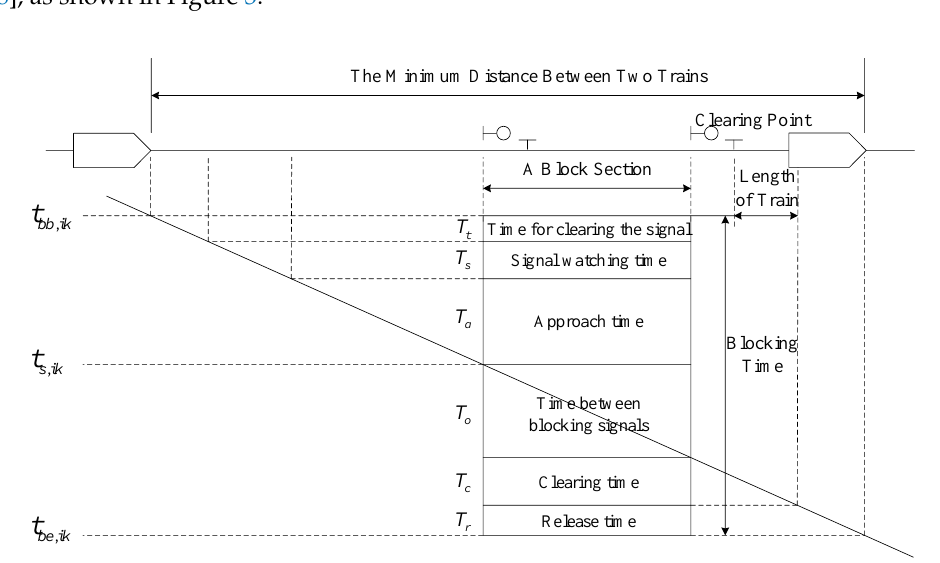
Figure 4. Diagram of the composition of the blocking time when a train has a scheduled stop. After a commercial stop, a train should leave that station. At this time, the approach time does not apply. Moreover, we used a clearing point to divide the block section behind the station into two parts. Figure 5 shows this situation.